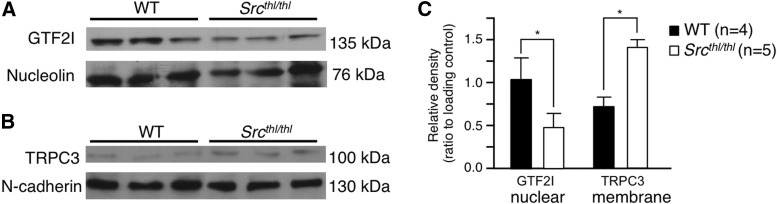
Altered cellular localization of TFII-I and TRPC3 in Srcthl
/thl mouse brain tissue. Western blot analysis was carried out on fractionated cell lysates from WT and Srcthl/thl adult mouse whole brain. Representative blots are shown (n = 4 WT, n = 5 Srcthl/thl). A, The nuclear fraction was probed with TFII-I antibody, with nucleolin as a loading control. B, The membrane fraction was probed with TRPC3 antibody, with n-cadherin as a control. C, Quantification of the Western blots. Data are expressed as mean ± SEM, *p < 0.05.